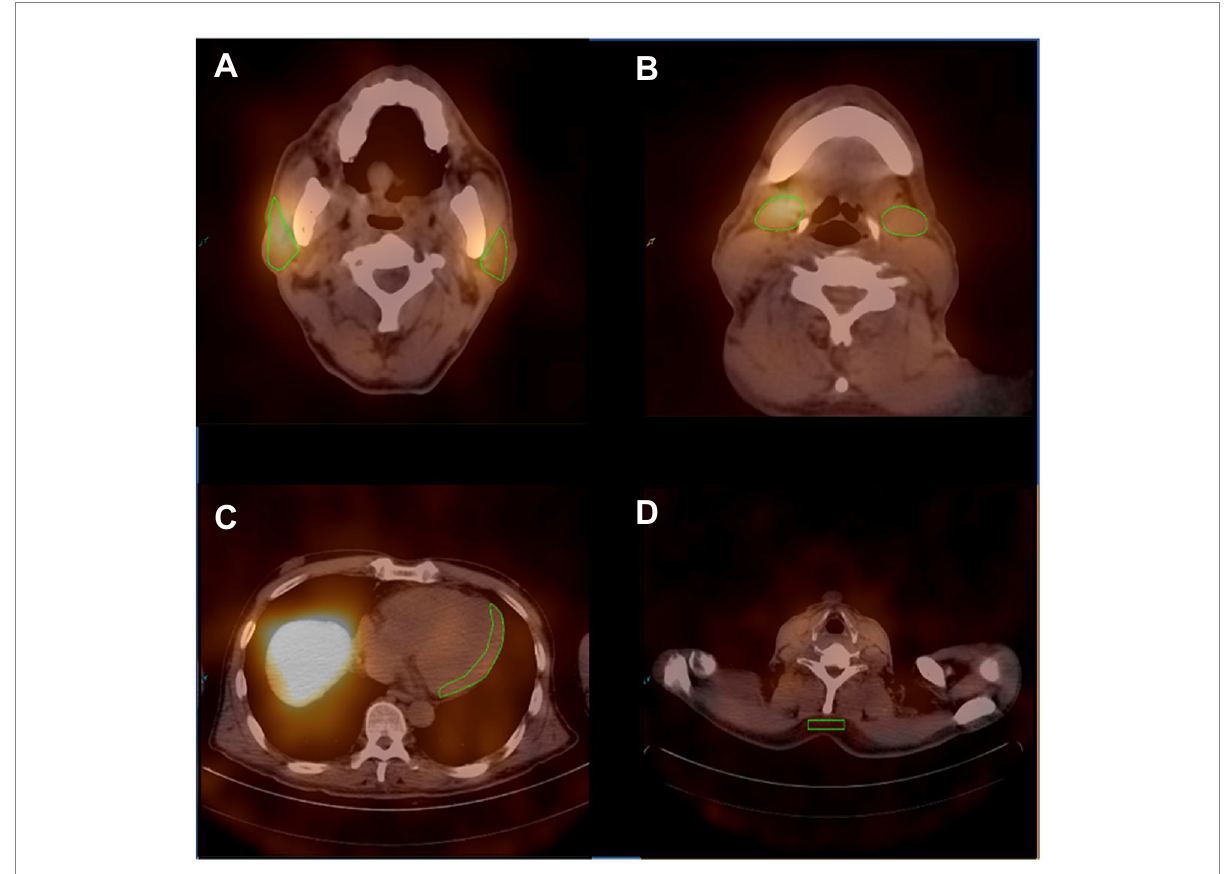
FIGURE 1 Representative ROIs of MIBG scintigraphy. (A) The ROIs of the bilateral parotid glands. (B) The ROIs of the bilateral submandibular glands. (C) The ROI of the left ventricular wall. (D) The ROI of the neck subcutaneous